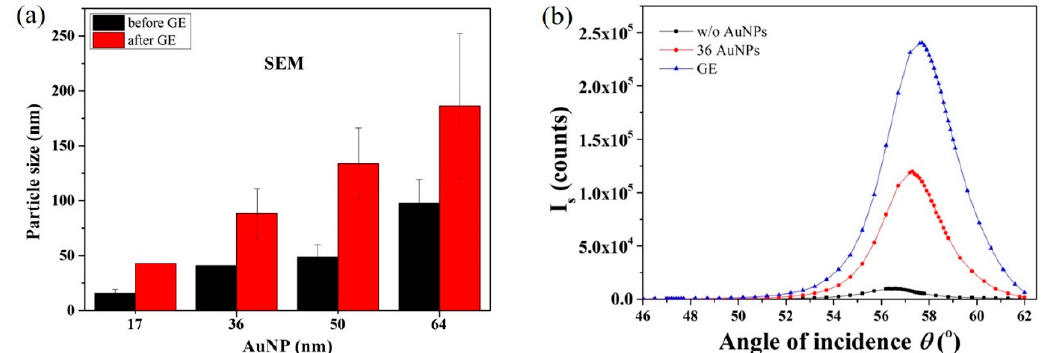
Figure 5. Angular reflectivity and scattering spectra as a function of the angle of incidence with or without the specific adsorption of AuNPs with diameters of ( a ) 17 nm, ( b ) 36 nm, ( c ) 50 nm and ( d ) 64 nm.